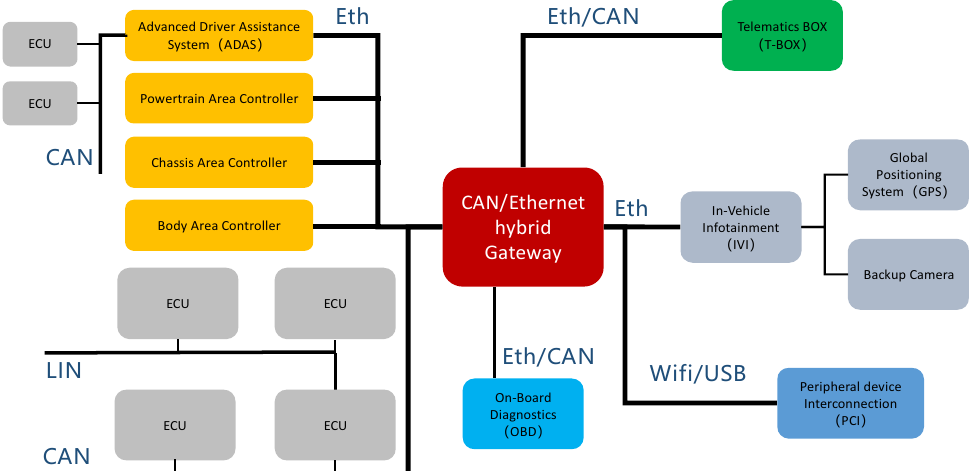
Figure 1. Example of an automotive hybrid gateway and domain controller topology.